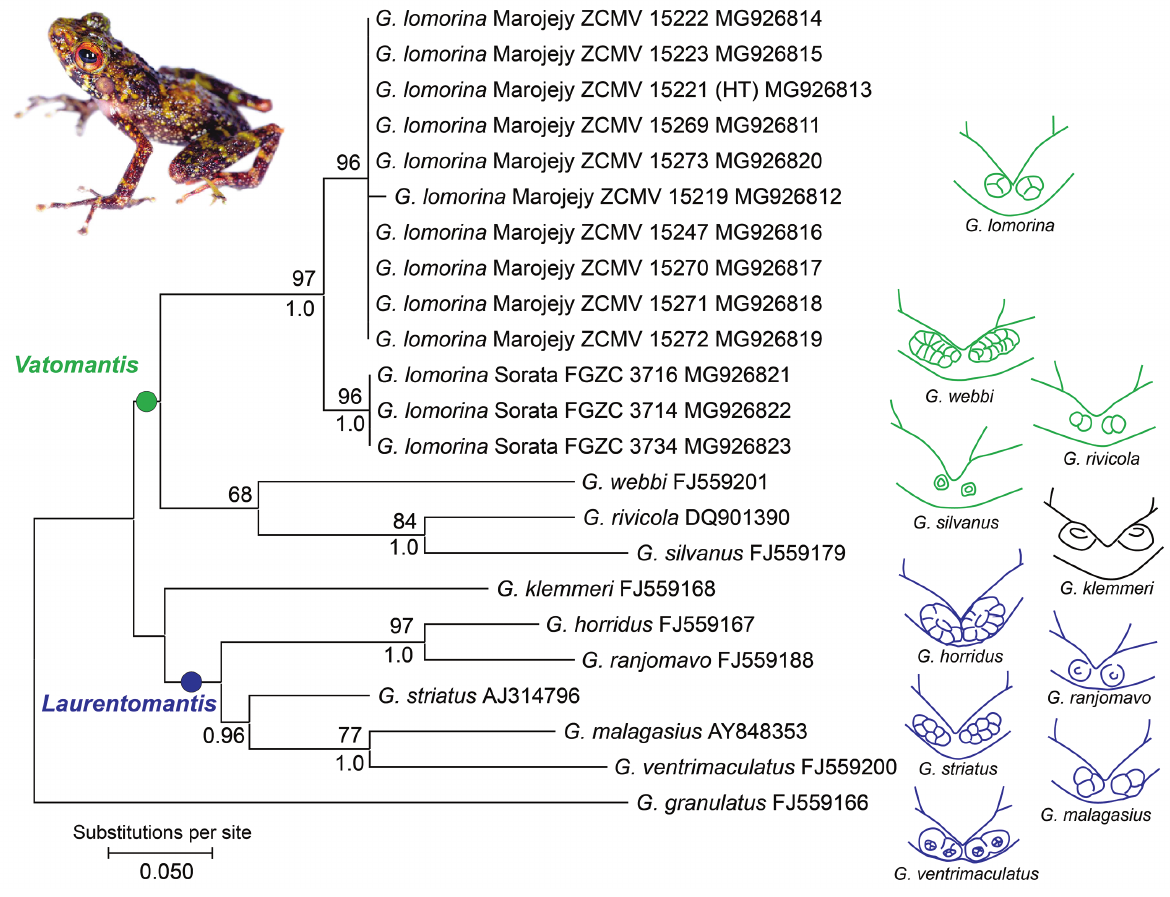
Figure 1. Preliminary phylogenetic tree of Gephyromantis ( Vatomantis ) lomorina sp. n., based on Maximum Likelihood analysis of a 532 bp fragment of the mitochondrial 16S rRNA gene. Numbers at nodes indicate bootstrap values in percent (500 replicates, above) and posterior probabilities from a Bayesian Inference analysis (20 million generations, below), shown only if >50 % (bootstrap) or >90 % (posterior probabilities). Each specimen/species is followed by the corresponding GenBank accession number used in the alignment. Schematic drawings of femoral glands of all species in the subgenera Laurentomantis and Vatomantis as well as of G. klemmeri are shown to the right of the phylogeny, and coloured according to the subgenus to which they are